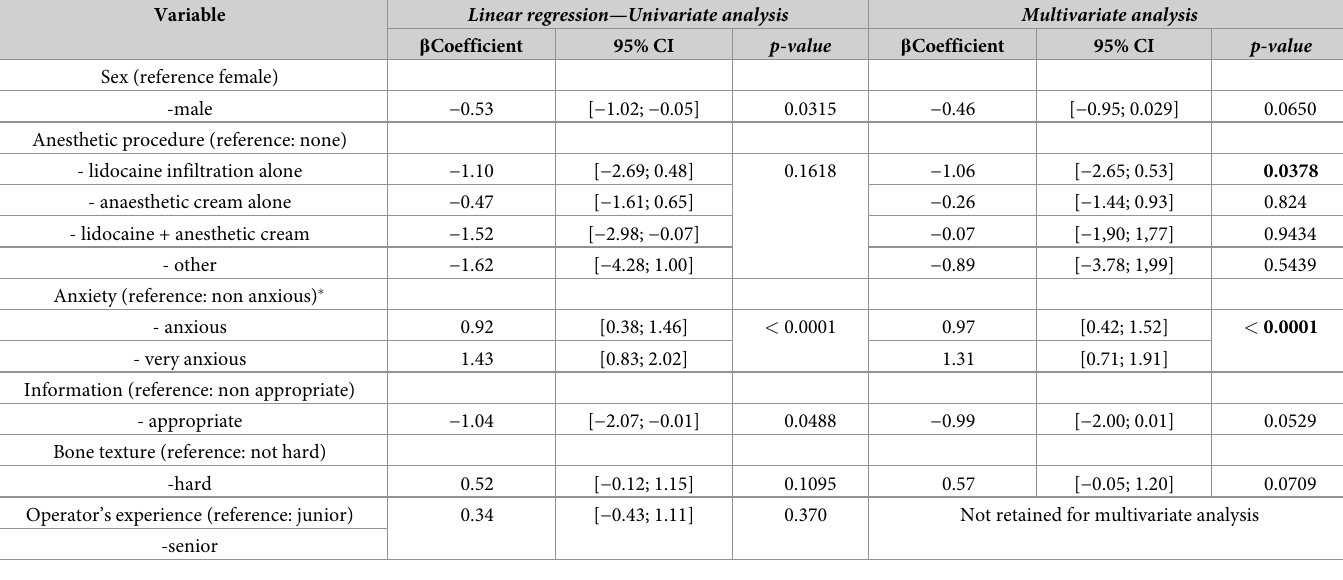
Table 4. Regression model of the NPRS score after sternal BMA. Variable Linear regression—Univariate analysis Multivariate